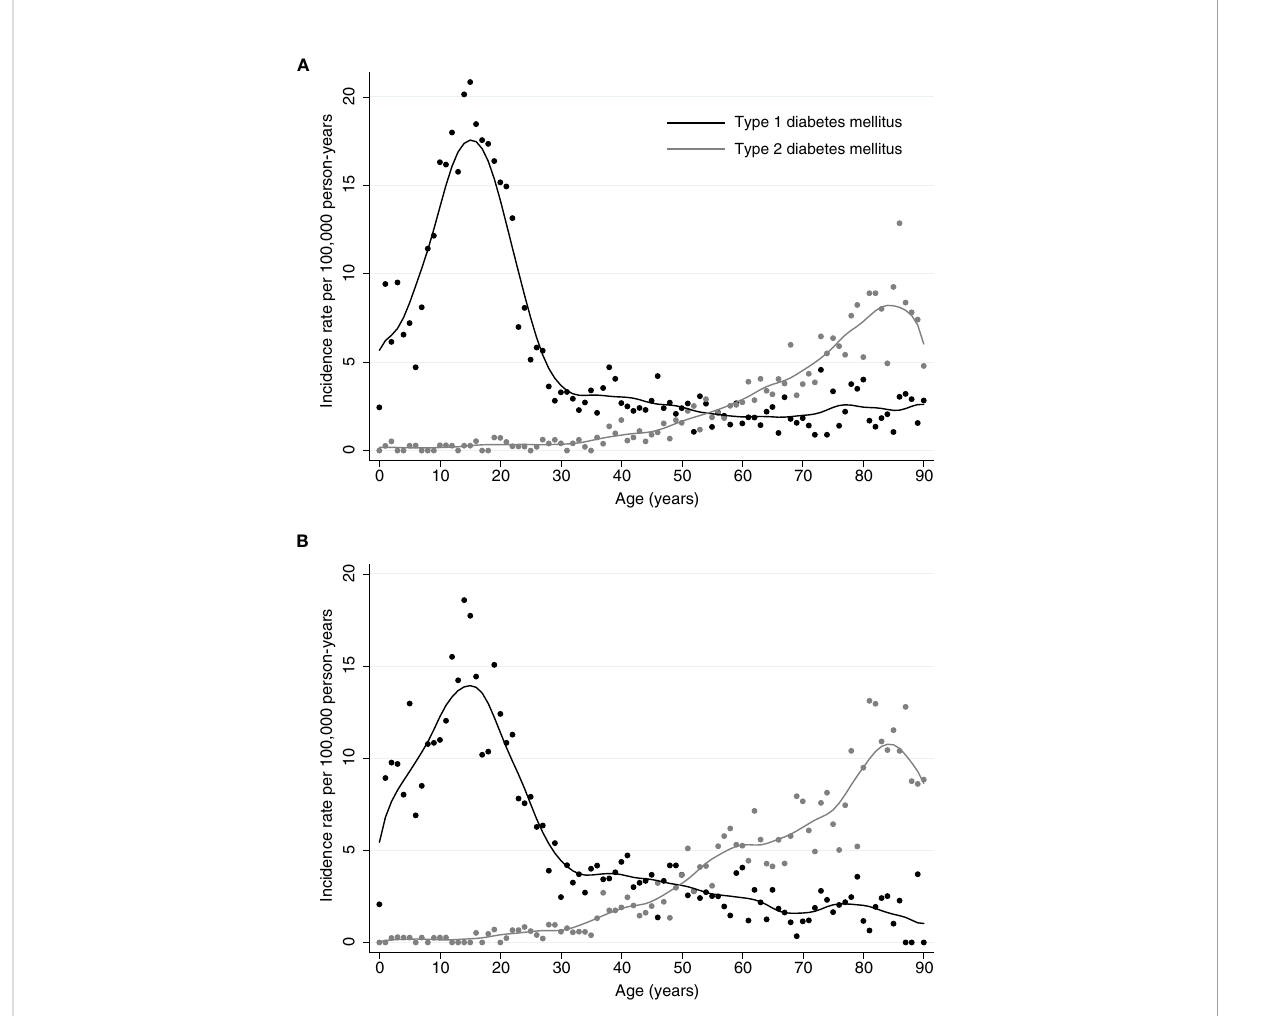
FIGURE 2 Incidence Rates of Diabetic Ketoacidosis. Incidence rates for diabetic ketoacidosis per 100,000 person-years for (A) female or (B) male patients with type 1 or type 2 diabetes, respectively. For both sexes, highest incidences for patients with type 1 diabetes occur within the adolescence and remain low from the age of 30 years. In patients with type 2 diabetes, incidences for ketoacidosis are lower and slowly increase with age from 30 with a peak around the age of 85